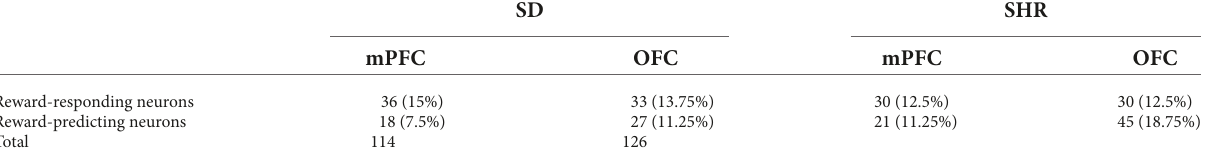
TABLE 1 Neuronal firing patterns in Sprague Dawley (SD) rat and spontaneously hypertensive rat (SHR). SD SHR mPFC OFC mPFC Reward-responding